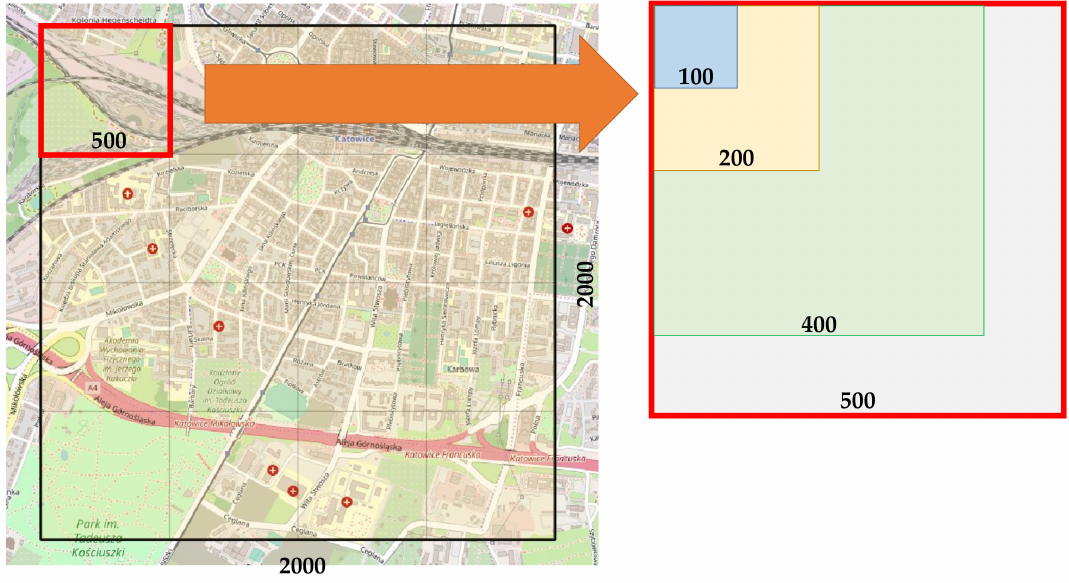
Figure 5. Division of the city area under study into a regular grid.